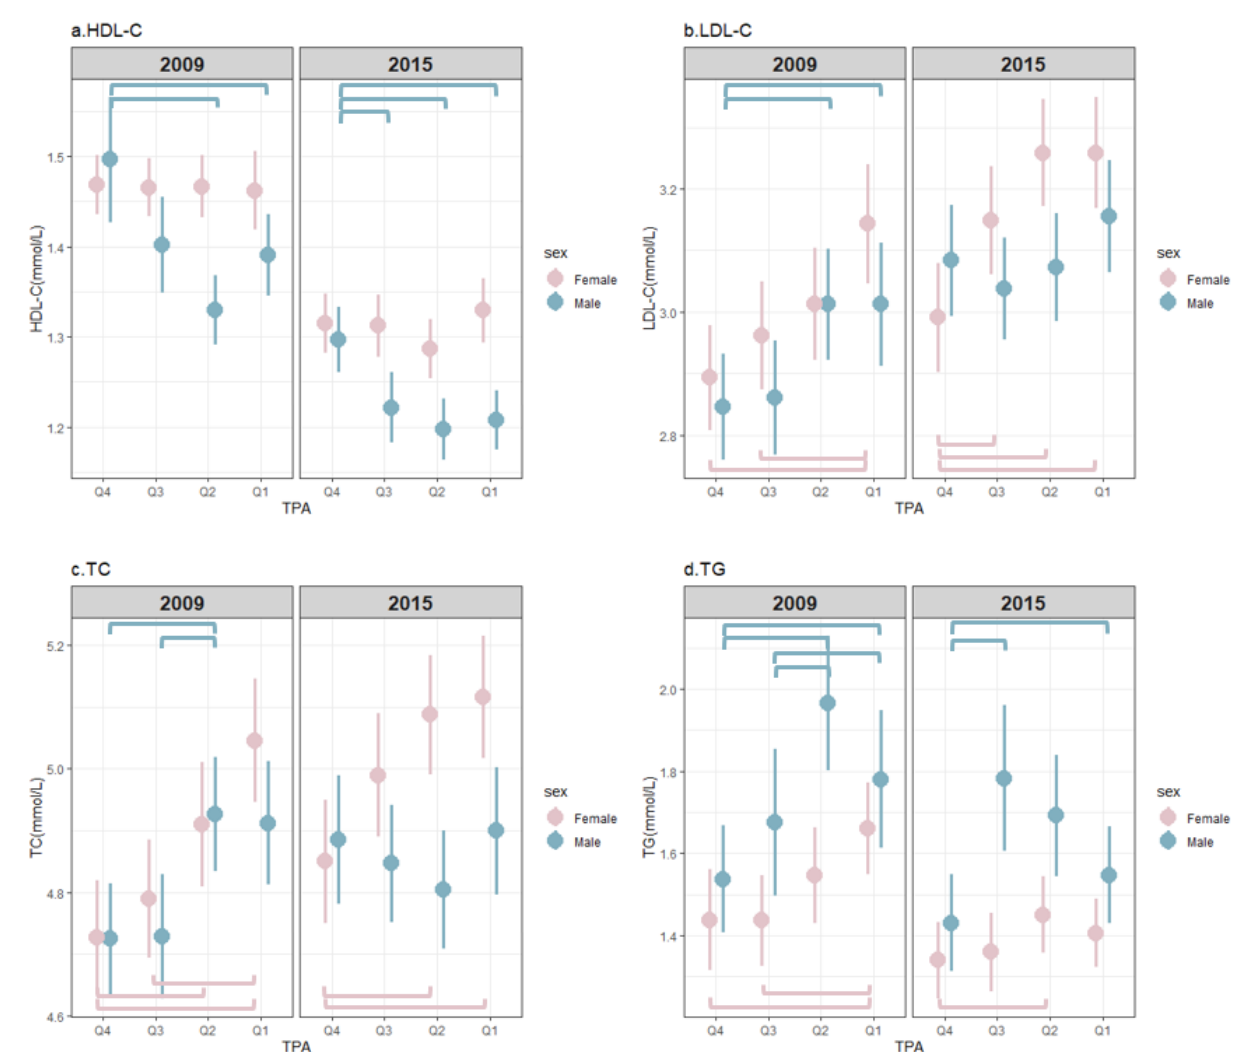
Figure 2. Three-dimensional distribution graph of the serum lipid variables by quartiles of total physical activity among Chinese adults from nine provinces in 2009 and 2015. HDL-C, high-density lipoprotein cholesterol; LDL-C, low-density lipoprotein cholesterol; TC, total cholesterol; TG, hypertriglyceridemia; TPA, total physical activity. Q = quartile. The square bracket indicates the statistically significantly difference between two groups, p < 0.05.